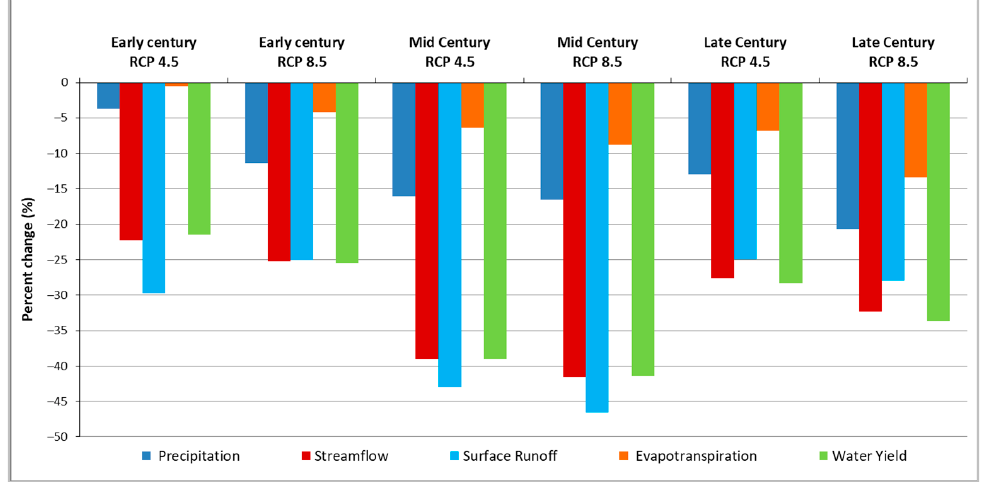
Figure 11. Simulated mean annual changes to key water balance components using linear/variance scaling methods.